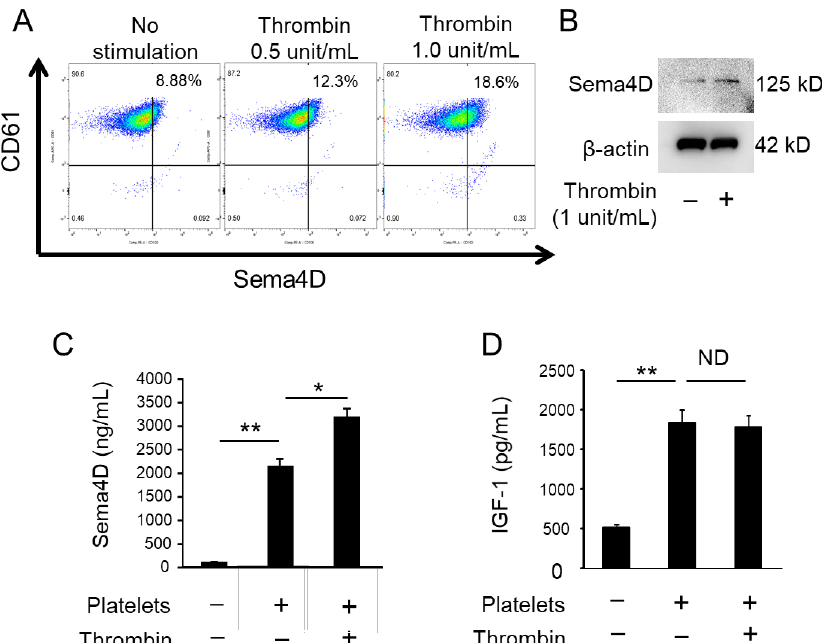
Figure 1. Sema4D production from TPs. Flow cytometry was performed to detect Sema4D on CD61+ platelets stimulated with and without thrombin (0.5, 1 unit/mL) ( A ). Sema4D and β -actin were detected in platelets cultured with/without thrombin (1 unit/mL) by Western blotting ( B ). Sema4D and IGF-1 in supernatant of platelets cultured with and without thrombin (1 unit/mL) were detected by ELISA ( C , D ). Data represent the mean ± SD of three independent experiments. Values are mean ± S.D. * p < 0.05, ** p < 0.01. ND: No statistically significant difference. +: Applied. − : Not